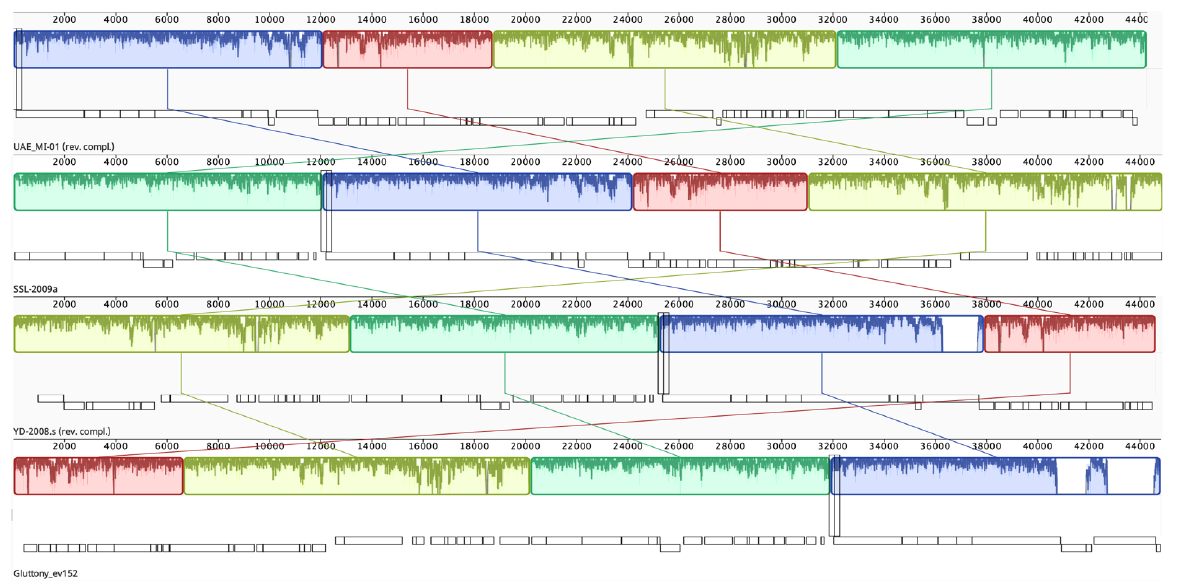
Figure 5. Whole genome alignment of the phage UAE_MI-01 and three phage genomes that were most similar to it as identified by a BLASTN search. The reverse complement of the UAE_MI-01 and YD-2008.s sequences were used so that the terminase genes are on the forward strand. The alignment was generated using progressiveMauve. Colored blocks match regions in different genomes.